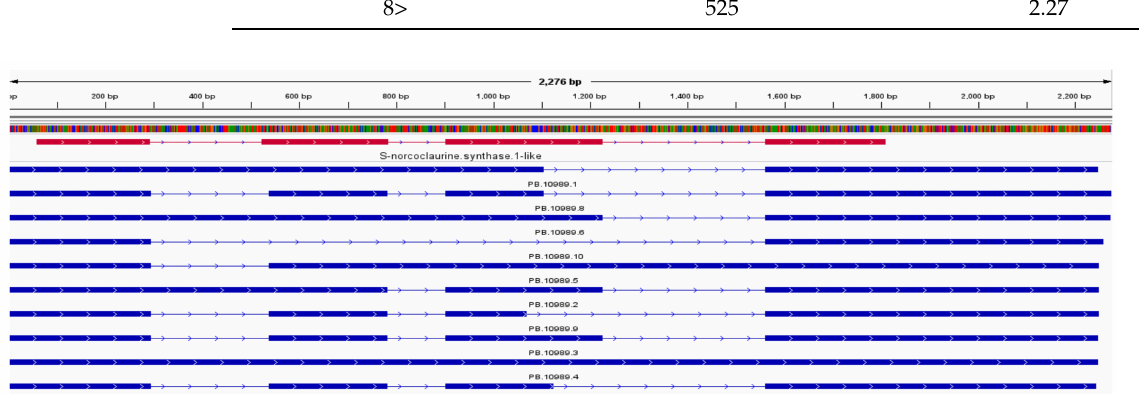
Figure 4. ( S )-Norcoclaurine synthase (NCS) transcriptome exhibiting isoforms; the red track represents the coding regions (CDSs) of the reference sequence according to the BLAST results, and the blue represents the exons of each